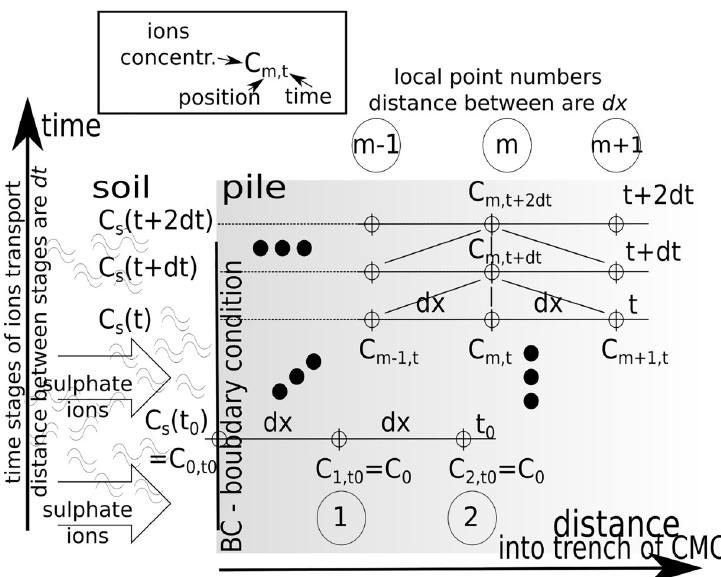
Fig 3. The procedure for numerical solution of transport issues for non-stationary boundary conditions and the functional dependence of the parameter and concentration C .